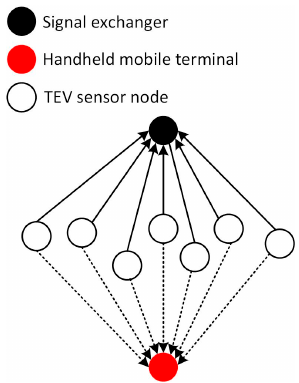
Figure 15. Topological graph of WSN: direct transmission model.